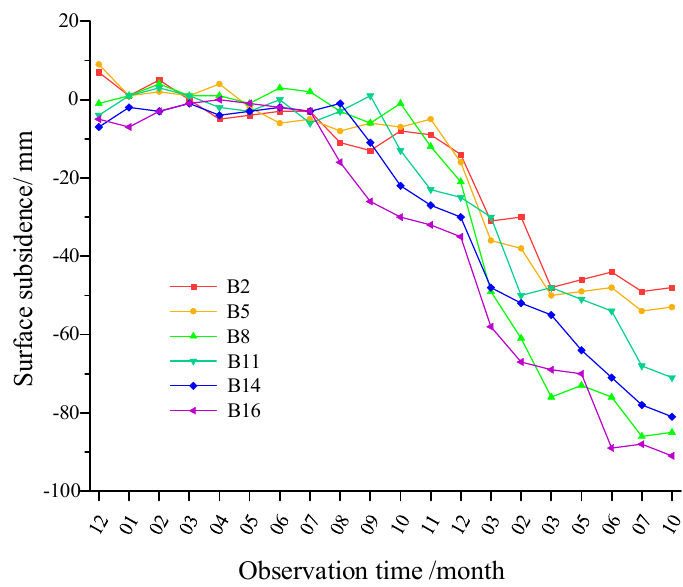
Figure 15. Settlement vs. time curve of measuring line B.